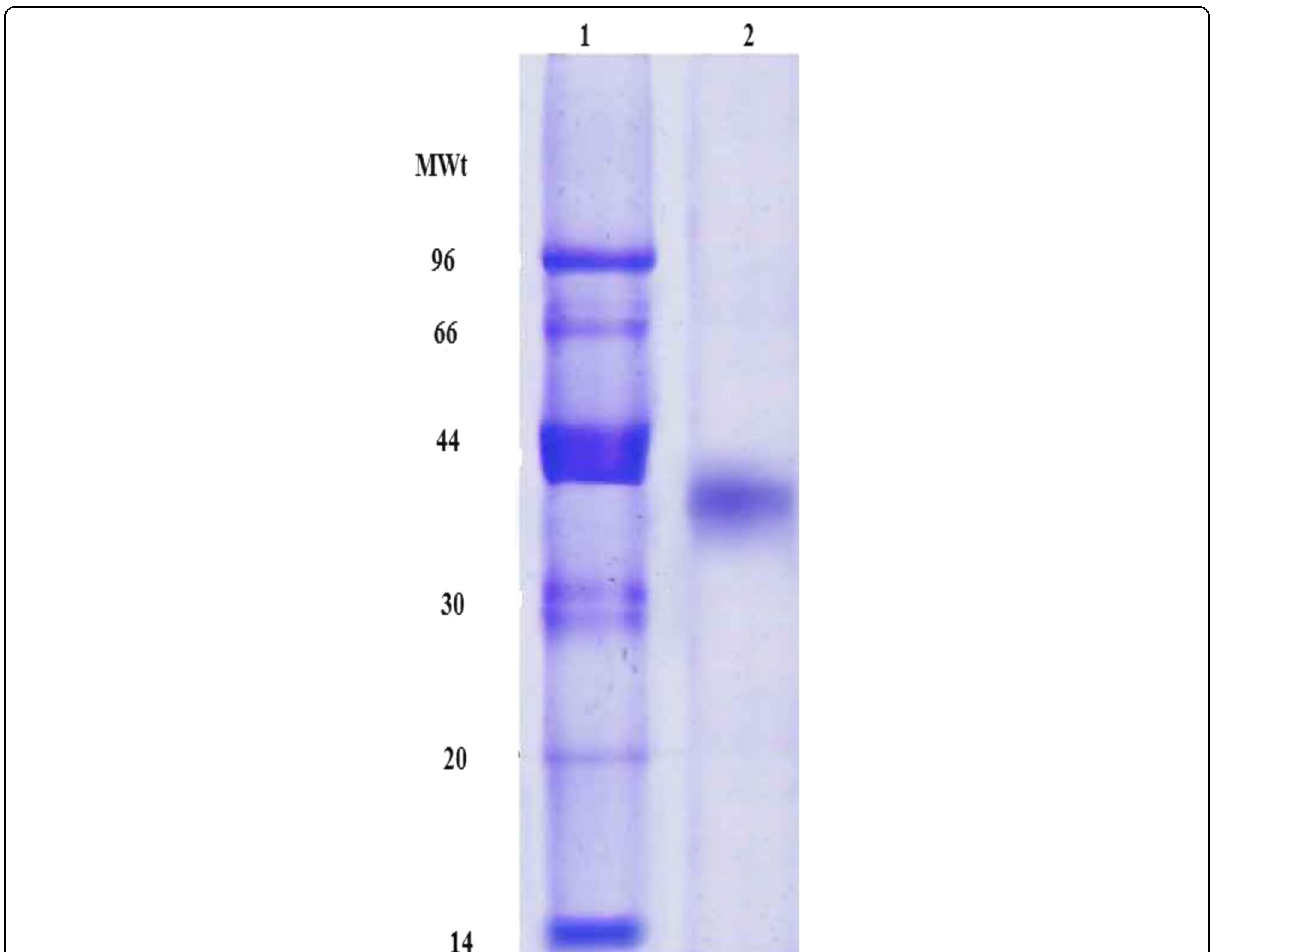
Fig. 4 SDS-PAGE for molecular weight determination for Sephacryl S-200 GPII. 1. Standard proteins, 2. Sephacryl S-200 GPII